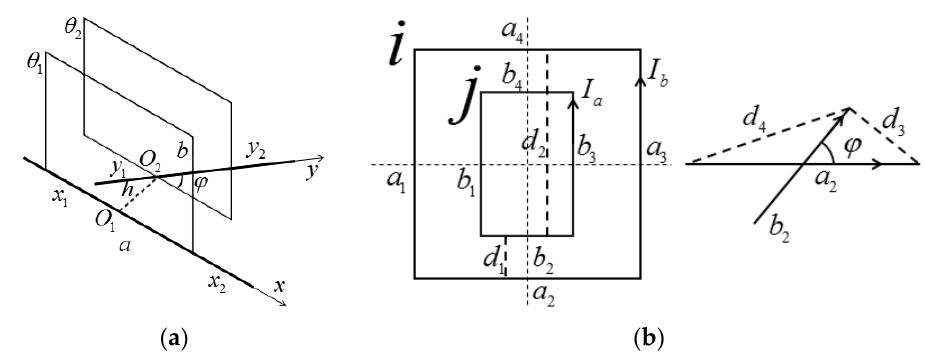
Figure 6. ( a ) General line segment position relation; ( b ) Diagrammatic drawing of single-turn coils.